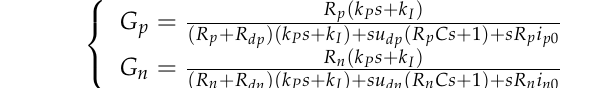
Table 3. Configuration of positive and negative loads.